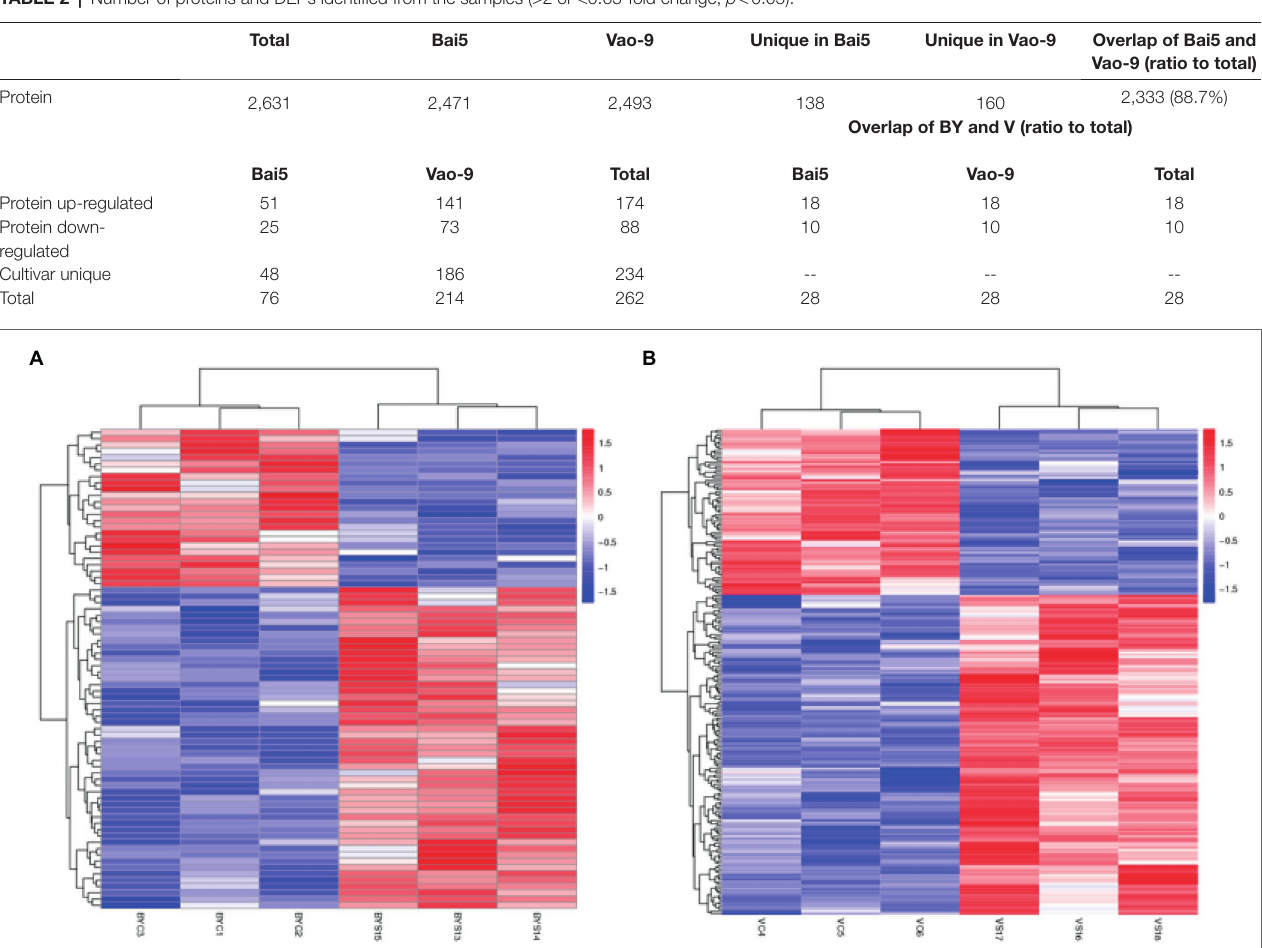
FIGURE 2 | Hierarchical cluster analysis of the differential expressed proteins (DEPs). (A) Hierarchical cluster analysis of the DEPs in Bai5; (B) hierarchical cluster analysis of the DEPs in Vao-9. BYC1, BYC2, BYC3, represent CK samples with three replicates; BYS13, BYS14, BYS15, represent the treated (nNaCl:nNa 2 SO 4 = 1:1) 150 mmol L − 1 with three replicates; VC4, VC5, VC6 represent CK samples with three replicates; and VS16, VS17, VS18, represent the treated (nNaCl:nNa 2 SO 4 = 1:1) 150 mmol L − 1 with three